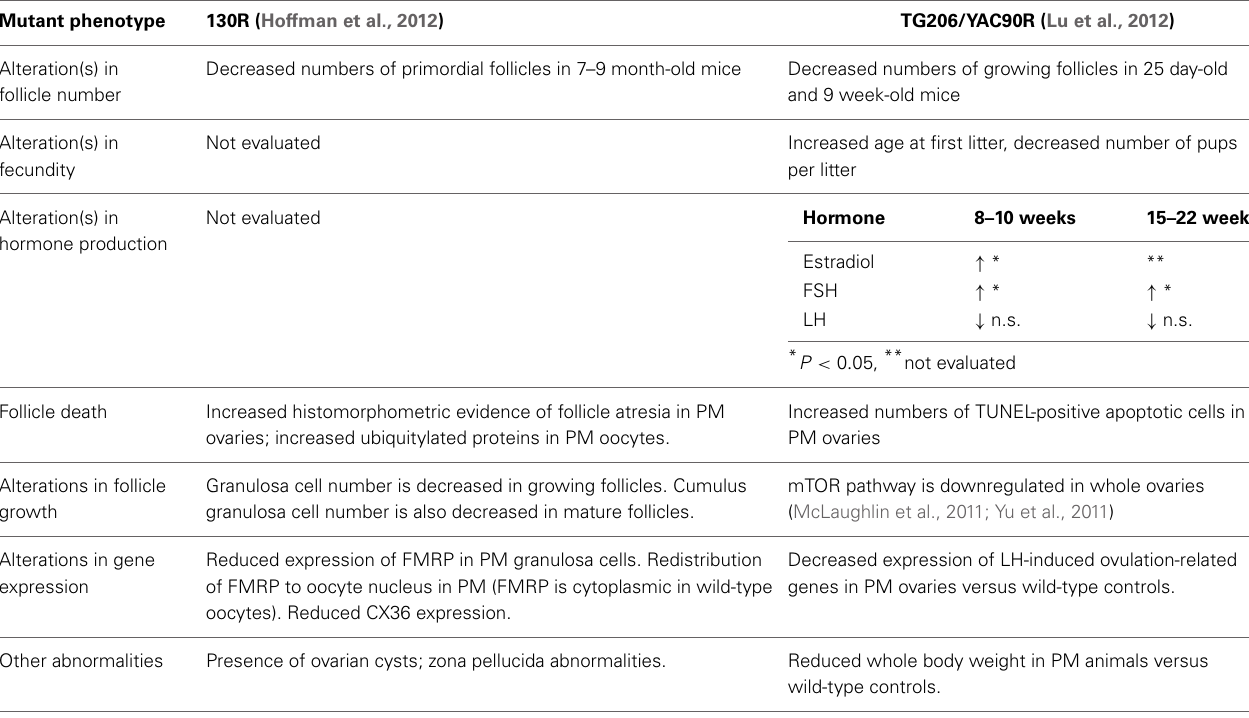
Table 2 | Mouse Models related to Ovarian Dysfunction and